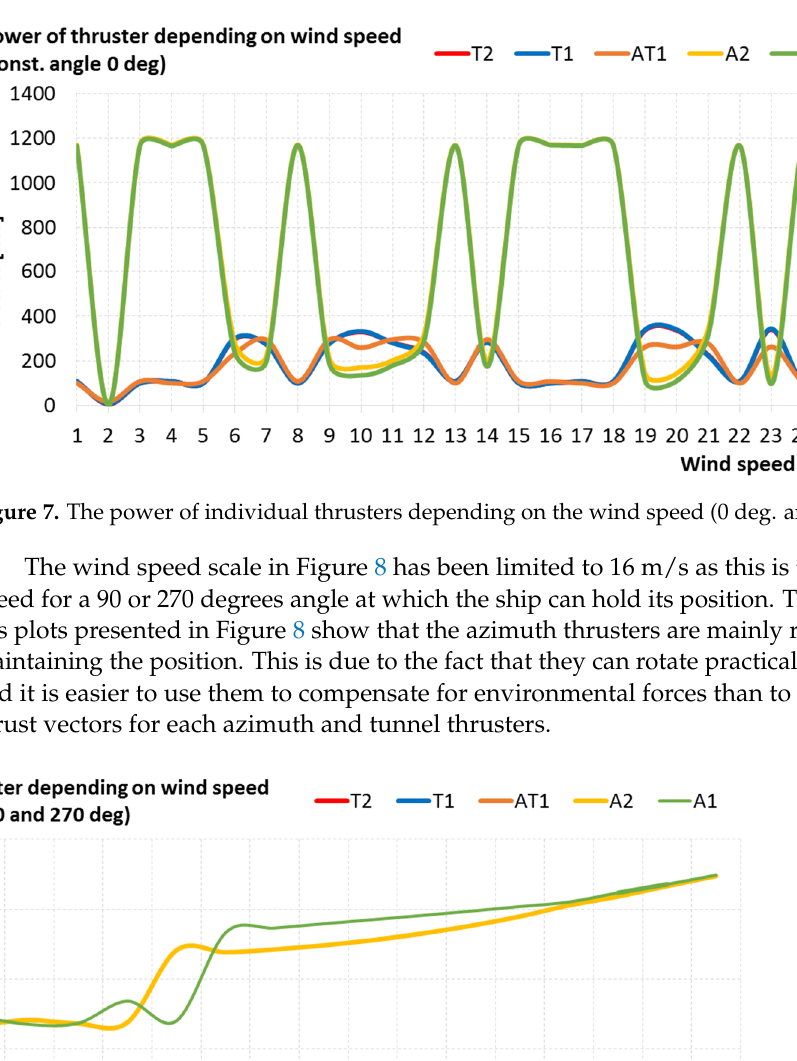
Figure 9. The power of individual thrusters depending on the wind speed (180 deg. angle). In order to determine energy consumption by thrusters, the positioning time and wind speed changes should be determined. Figure 10 shows a graph of changes in wind speed during 10 h of vessel positioning.